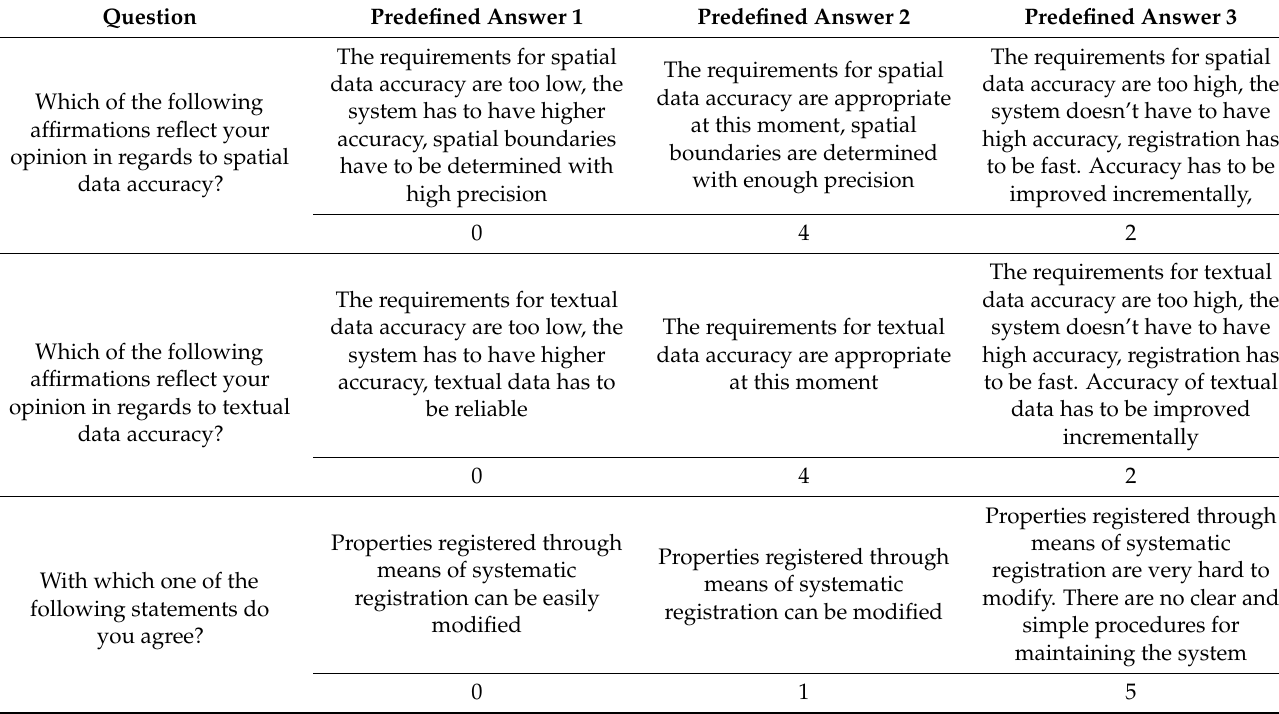
Table 8. Requirements of accuracy for geometric data. Requirements of accuracy for textual data. Ease of modification of the data registered through systematic land